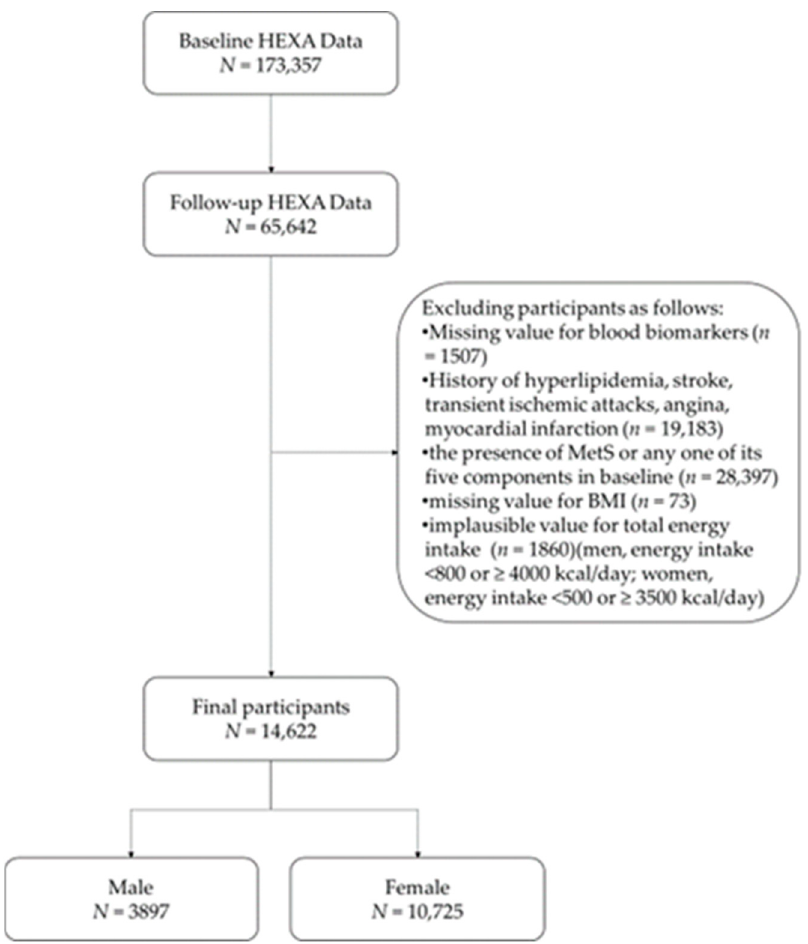
Figure 1. Selection flowchart of study participants. BMI, body mass index; HEXA, Health Examinees; MetS, metabolic syndrome.